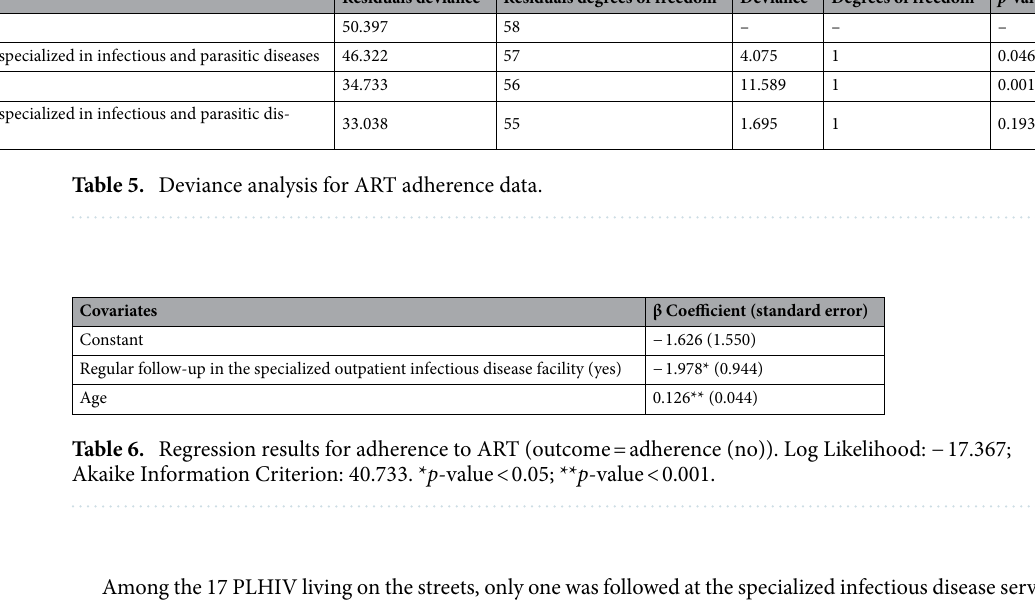
Table 4. Adherence to ART according to clinical–epidemiological data ( n = 61). Data source: Medication Logistics Control System (SICLOM) and data obtained from the review of outpatient and hospital records of